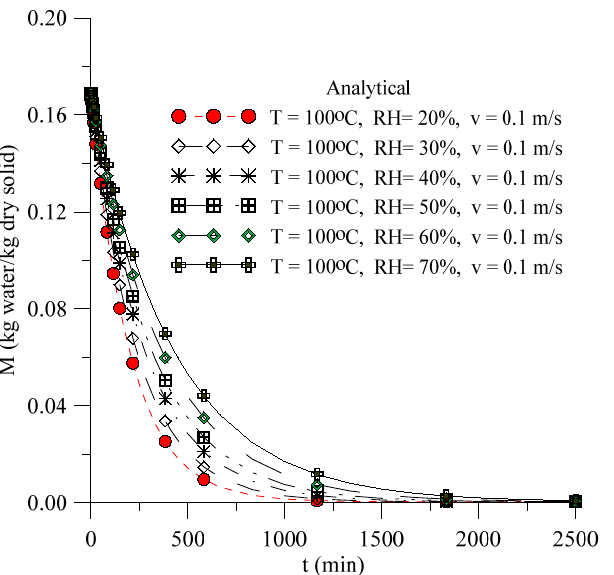
Figure 7. Average moisture content of industrial ceramic brick as a function of time for different relative humidity of the drying air.